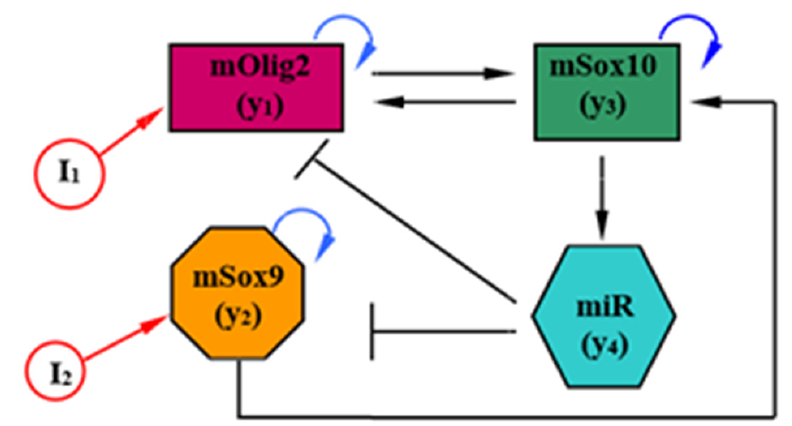
Figure 1. Scheme of the reduced model. In a recent study of ours [32], the role of I 1 , I 2 and k 2 for the existence of stable and unstable (sustained oscillations) behaviors in system (1) was demonstrated through a numerical approach. Specifically, after direct numerical simulations, we ascertained that (i) for some relevant values of k 2 , I 1 and I 2 , system (1) is stable/unstable; (ii) depending on the values of k 2 , I 1 and I 2 , system (1) has one/two/three equilibria. Continuing with the study of this system, a new qualitative analysis of system (1) was performed according to the theory of Lyapunov–Andronov, and the new results can be cross-referenced using new numerical experiments